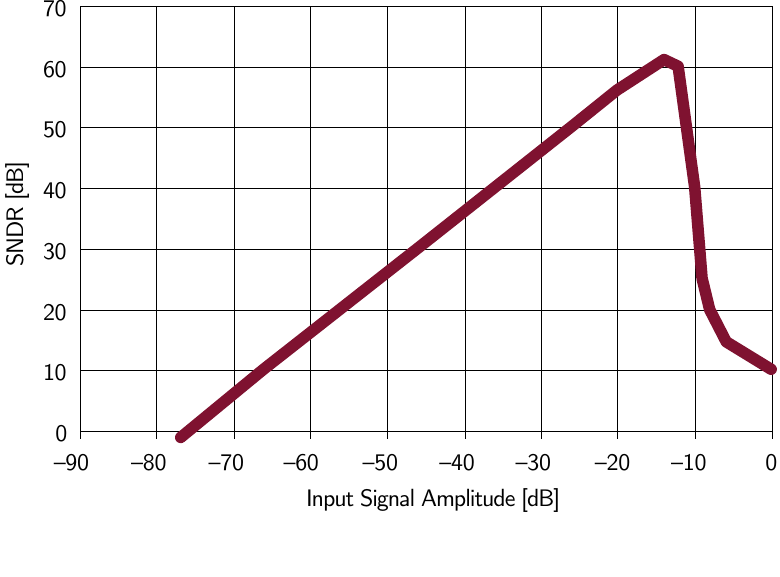
Figure 9. Measured SNDR as a function of the input signal amplitude (example